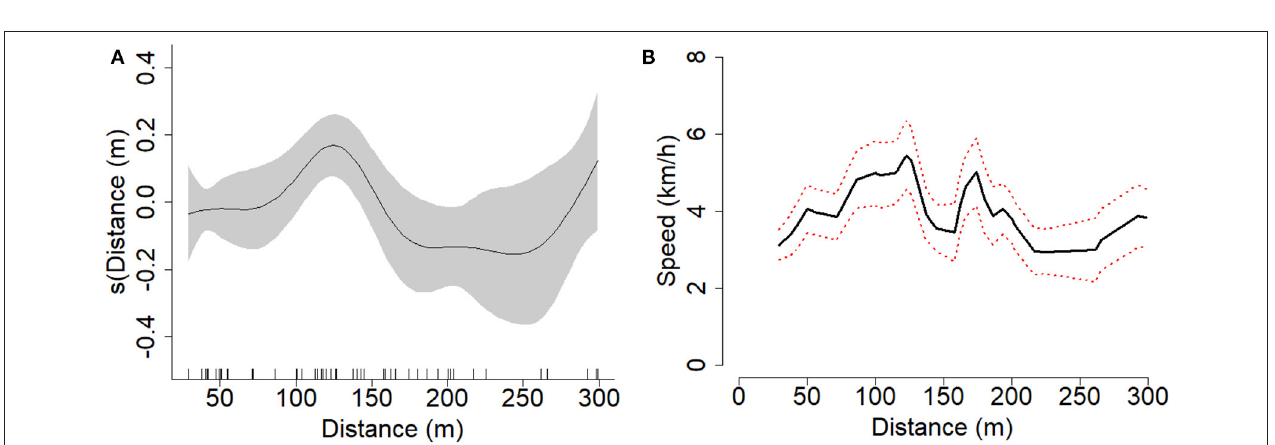
FIGURE 3 | Results from the best fit generalized additive model (GAM) for humpback swim speed showing (A) model parameter estimates of vessel distance to focal group and (B) model predicted swim speed based on vessel distance. The shaded and dashed lines represent the 95% confidence intervals of the parameter estimates and fitted values, respectively. The vertical ticks on image A indicate the locations of observations (i.e., a